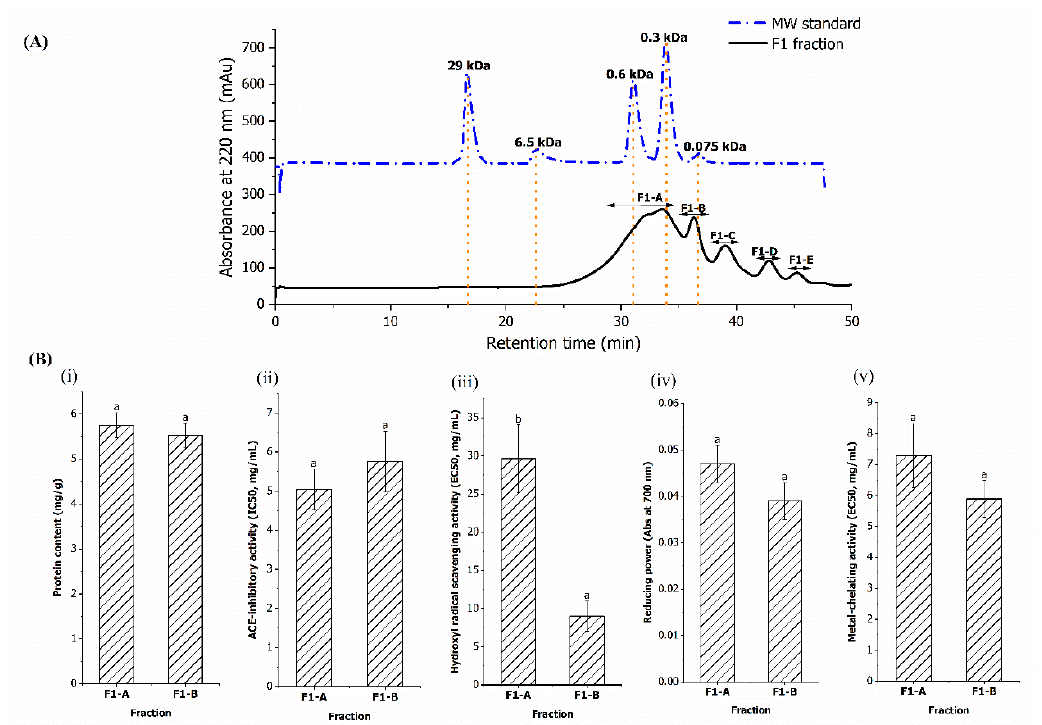
Figure 4. ( A ) The elution profile of F1 fraction on a Superdex Peptide 10/300 GL gel filtration col ‐ umn. ( B ) The protein content and bioactivities of the collected fractions (F1 ‐ A and F1 ‐ B). The values represent the mean ± SD. Means without a common letter (a, b) on the bars indicate significant difference at p < 0.05.